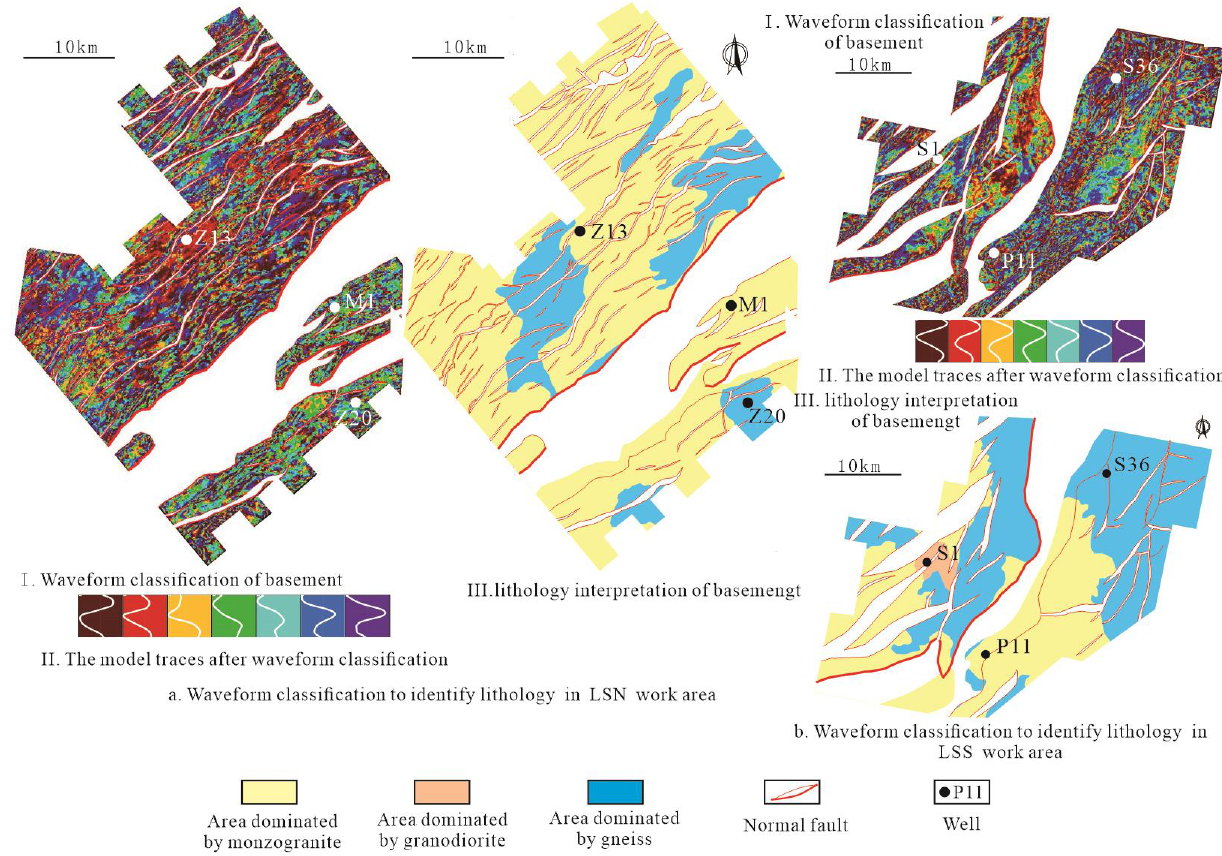
Figure 8. Waveform classification of basement rocks and lithological interpretation in the LS depres- sion. Note: In ( a ), I is the result of wave classification of basement in the LSN work area, II is the model traces divided by wave classification, and III is the lithology interpretation of basement in the LSN work area based on wave classification. In ( b ), I, II and III are the same as those in ( a ), except that the work area is LSS work area.